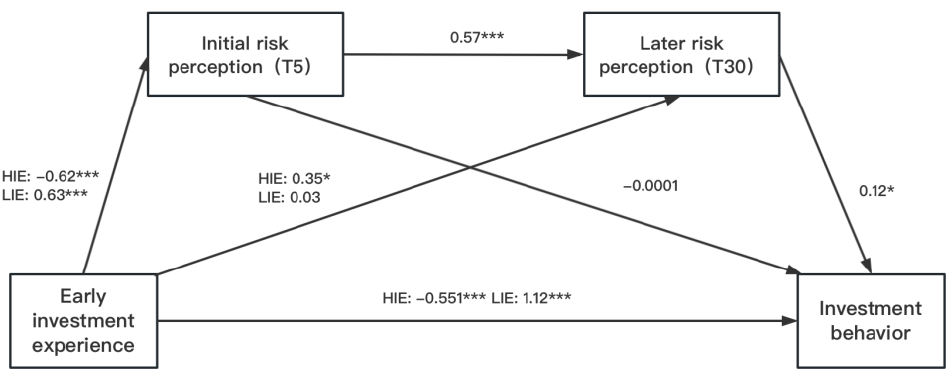
Figure 2. The chain-mediating role of initial risk perception and later risk perception between investment experience and investment decision and behavior. Notes: HIE, High-risk investment experience; LIE, Low-risk investment experience. * p < 0.1, *** p < 0.001. Coefficients in the Figure 2 are partially standardized because of the multicategory indicators of early investment experience. Table 2. Partially Standardized Effect and 95% CIs for Direct and Indirect Effects.